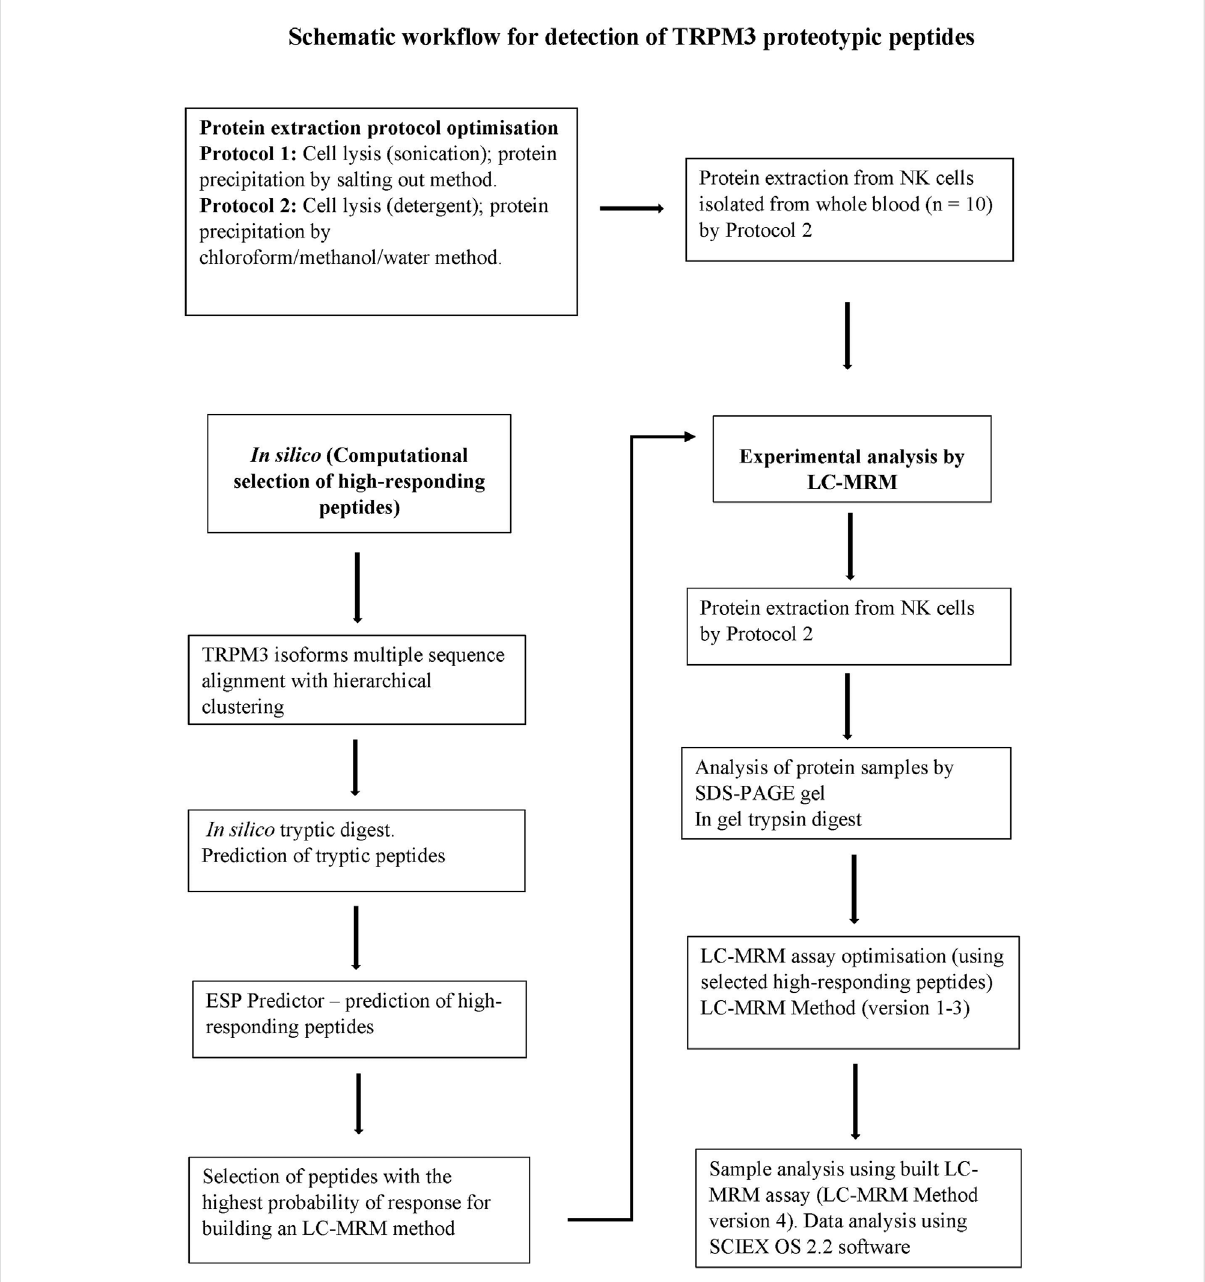
FIGURE 1 A schematic work fl ow for the detection of TRPM3 signature peptides by LC-MRM method. TRPM3 isoform sequences were computationally digested in silico to produce a set of predicted tryptic peptides. Tryptic peptides were input into the enhanced ESP predictor and a subset of high- responding peptides (peptides with the highest ion-current response deemed more likely to provide the best detection response) were selected to build the experimental LC-MRM method. LC-MRM method versions 1 – 3 were employed during optimization monitoring peptides within a selected time window (increasing signal intensity and improving detection of peaks). Undetectable peptides were removed from the fi nal method. LC-MRM Method version 4 was fi nally employed to target and monitor a few selected high-responding TRPM3 surrogate peptides in extracted protein samples, evaluating detectability of the monitored